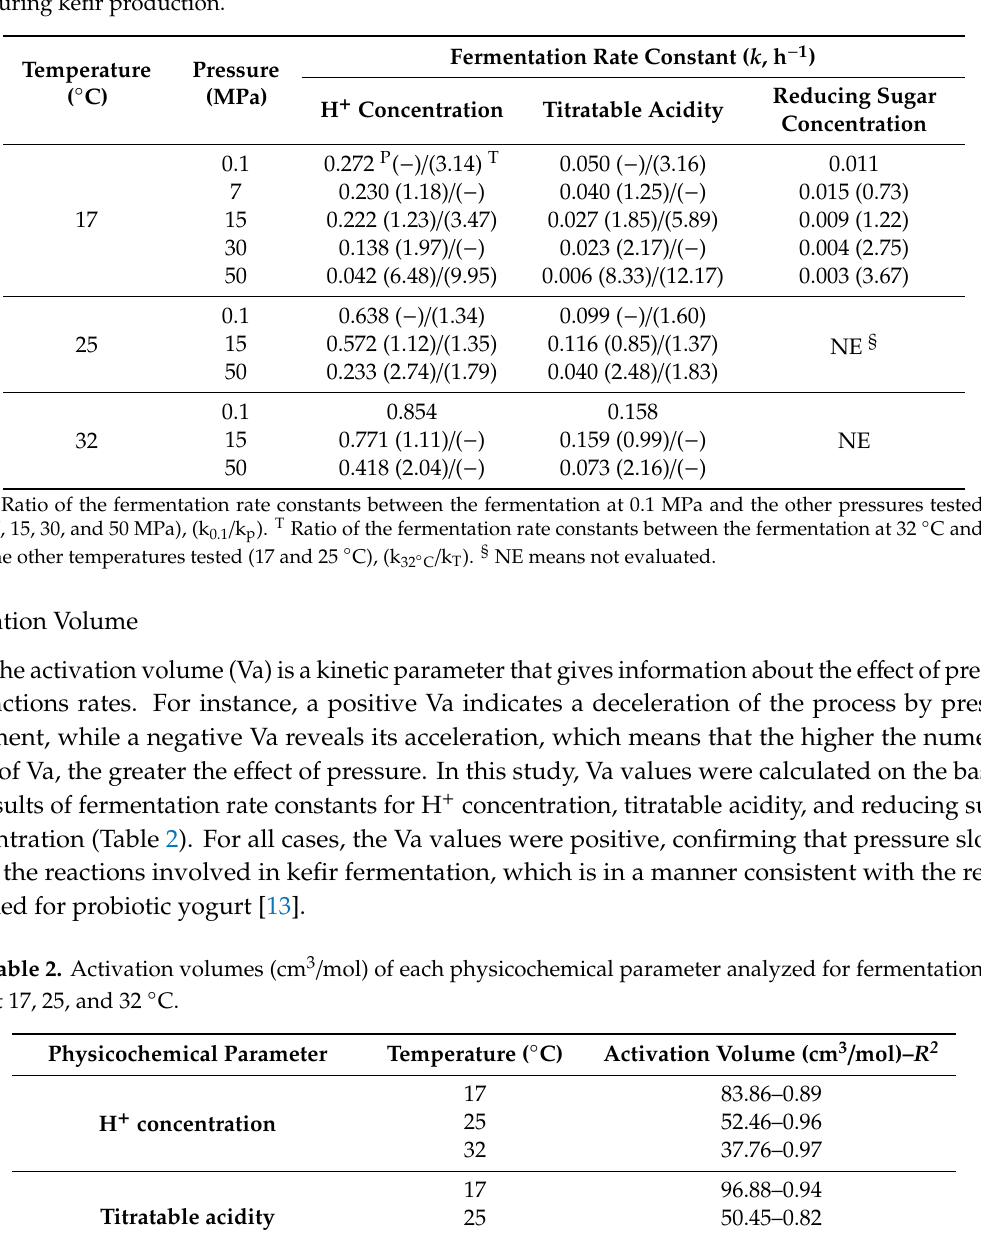
Table 1. Fermentation rate constants (k, h − 1 ) for H + concentration, titratable acidity, and reducing sugar concentration under di ff erent combinations of pressure (0.1–50 MPa) and temperature (17, 25, and 32 ◦ C) during kefir production.